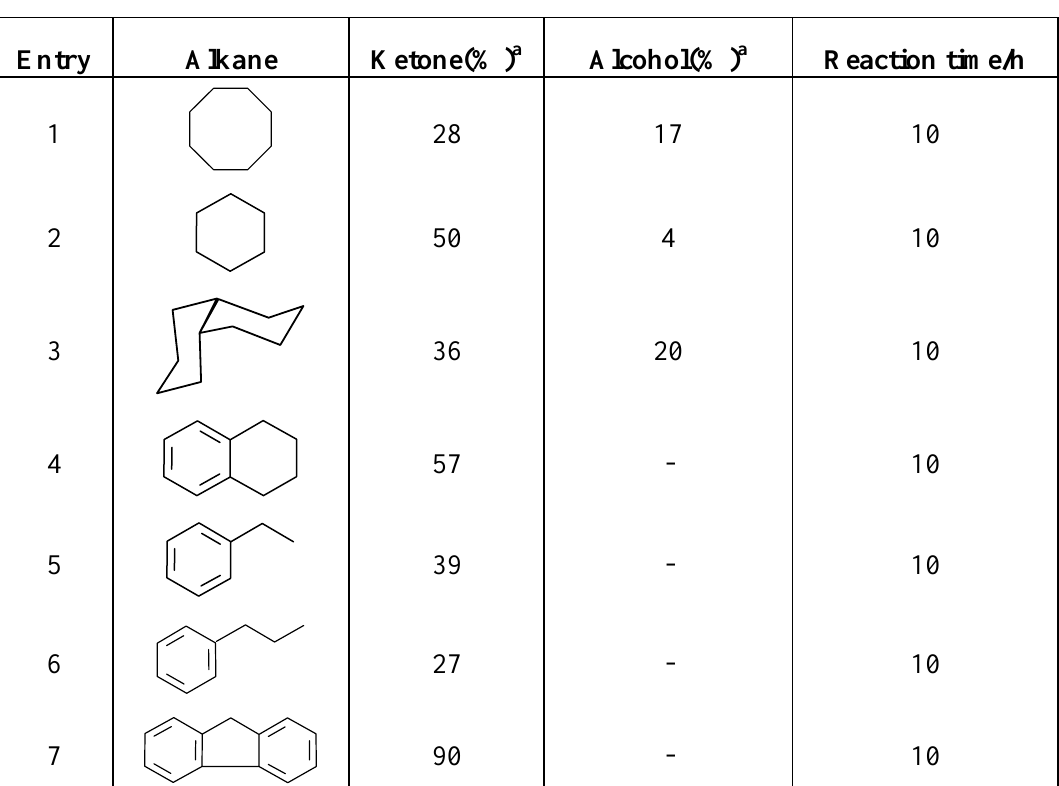
Table 2: Hydroxylation of alkanes with NaIO Ad-400 in presence of imidazole at room